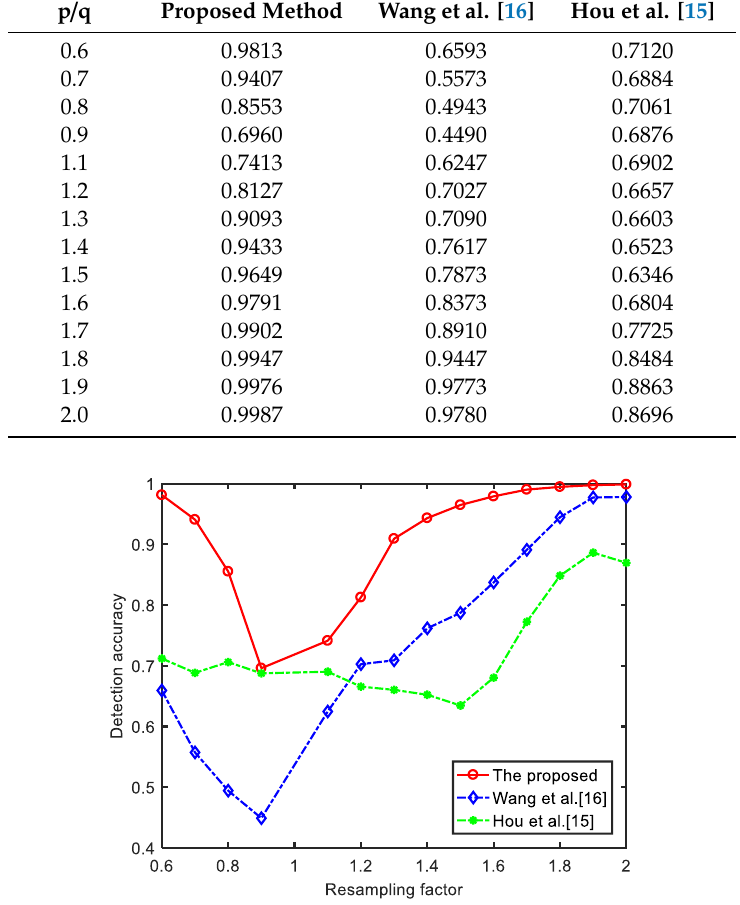
Figure 9. Comparison of the accuracy of p/q from 0.6 to 2. Table 4. Mixed resampling detection results of the proposed method and the state-of-the art studies.